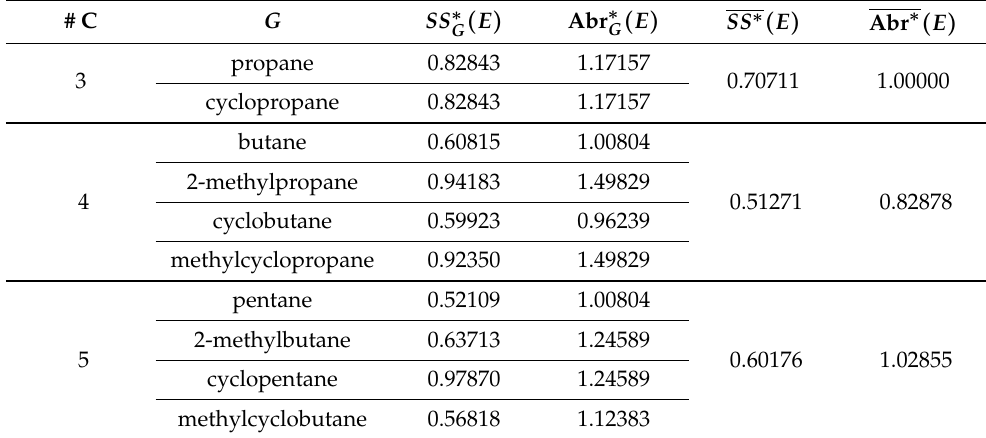
Table A2. Modified structure sensitivity and modified abruptness with average values, Part